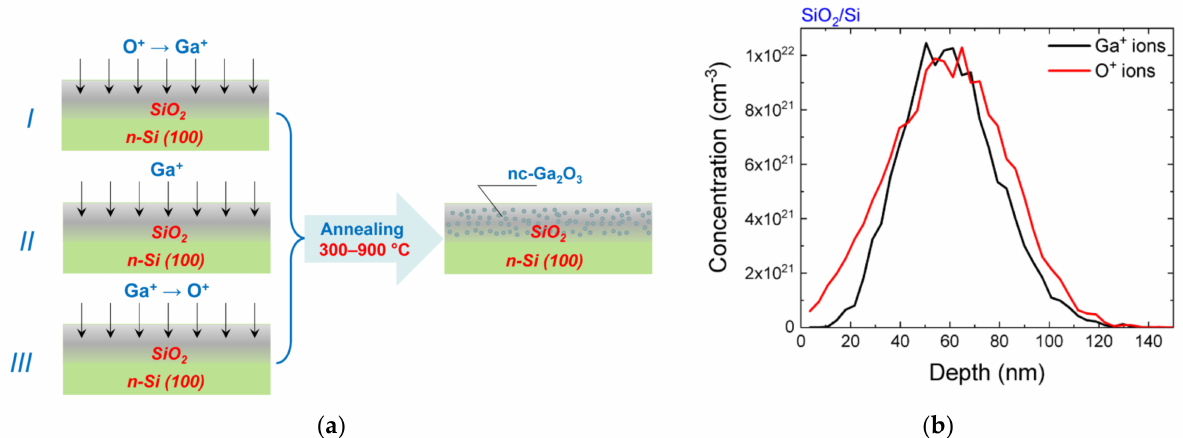
Figure 1. ( a ) Scheme of used variants of ion-beam synthesis of nc-Ga 2 O 3 ; ( b ) SRIM-calculated distribution of implanted gallium and oxygen